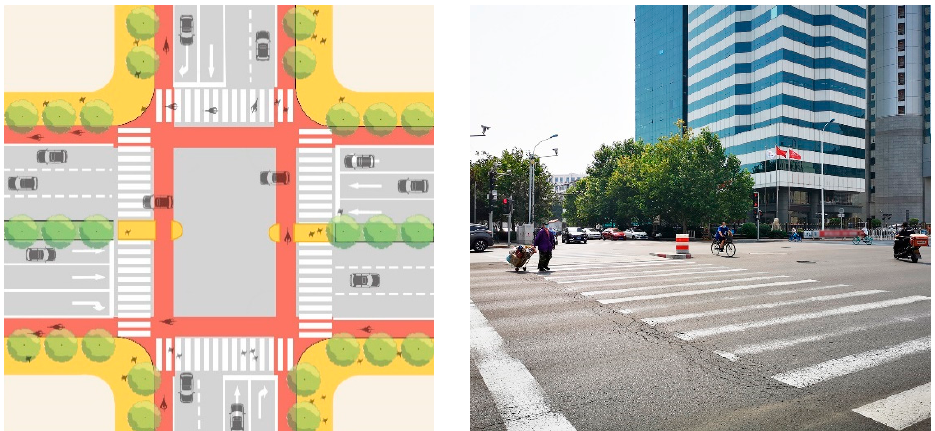
Figure 19. Right Transductive Island of Intersection between Xijing Road and Liuwei Road.